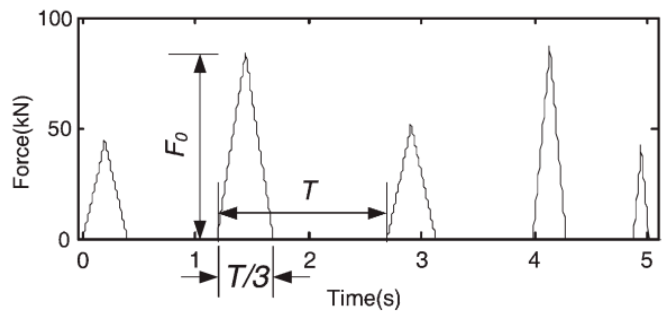
Figure 7. Simplified random ice force model on the cone structure.